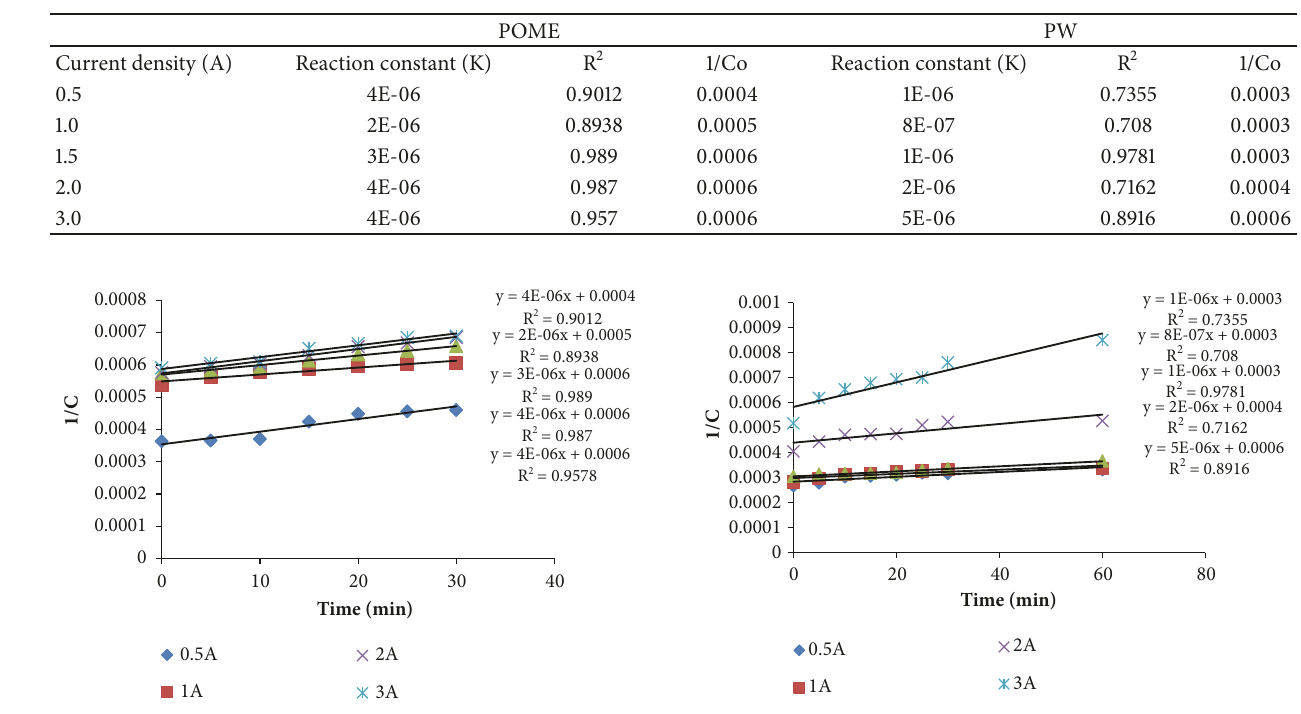
Table 4: Second-order kinetic parameters for POME and PW.